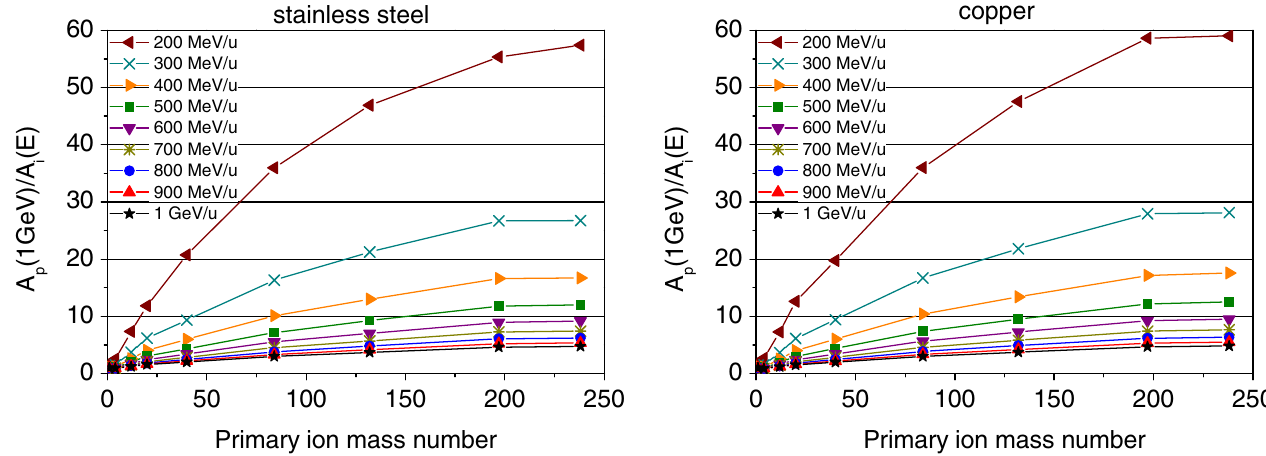
FIG. 10. (Color) Scaling factor for the beam-loss tolerance as a function of ion mass for the bulky target. The scaling factor is ð 1 GeV Þ , to the normalized activity induced by represented by the ratio of the normalized activity induced by 1 GeV proton beam, A p ð E Þ . The activities were calculated by FLUKA at the end of irradiation. The relative standard the beam of interest at given energy, A i uncertainty of the presented data is less than 0.89%.